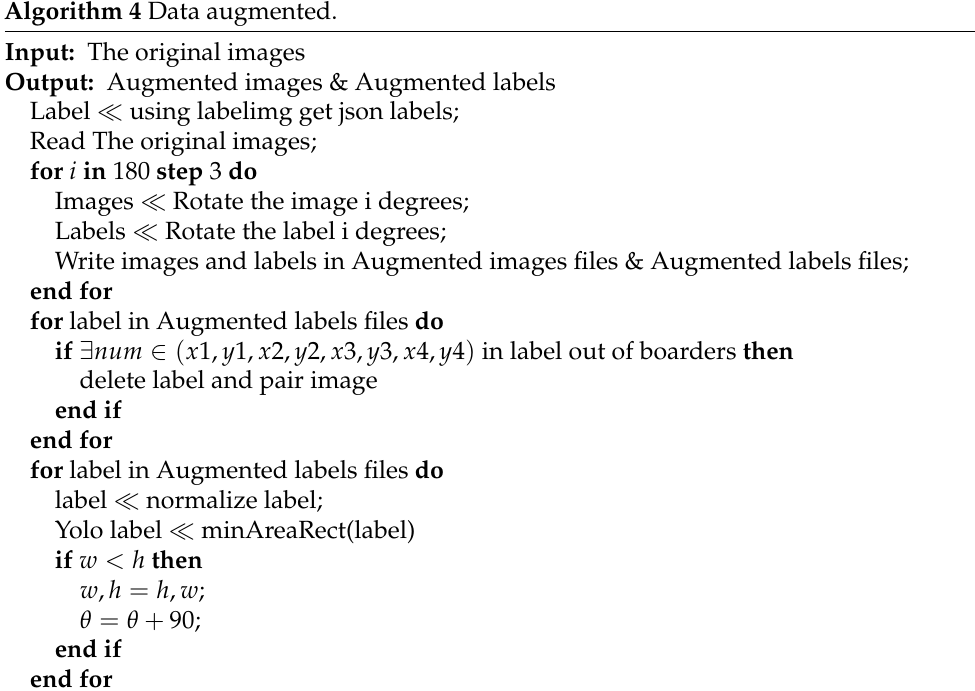
Algorithm 4 Data